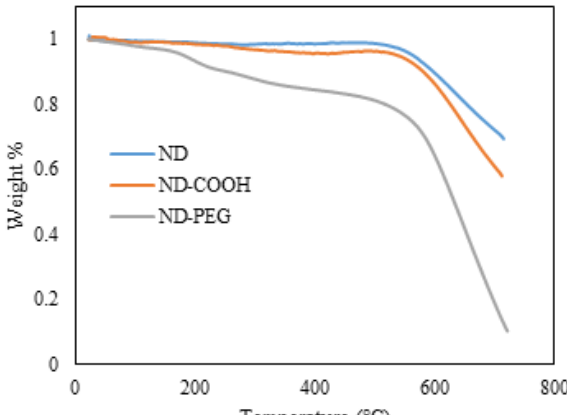
Fig. 2. TGA curves of pristine ND, ND-COOH and ND-PEG nanoparticles.